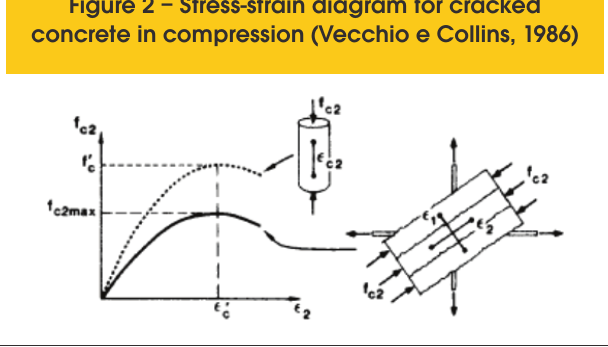
Figure 2 – Stress-strain diagram for cracked concrete in compression (Vecchio e Collins,